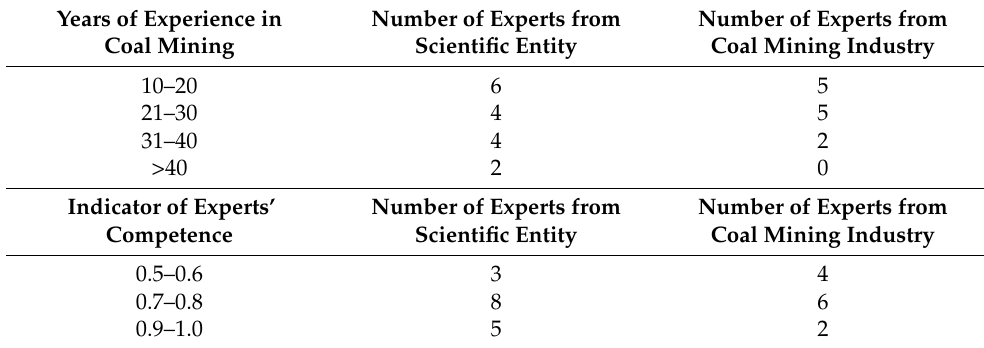
Table 2. Summary of expert